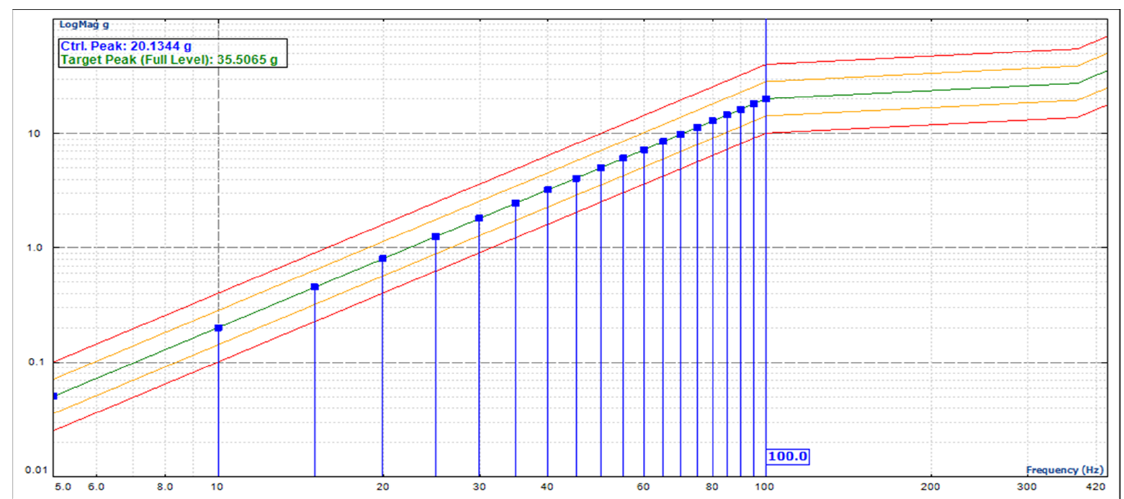
Figure 16. Acceleration response for various natural frequencies.